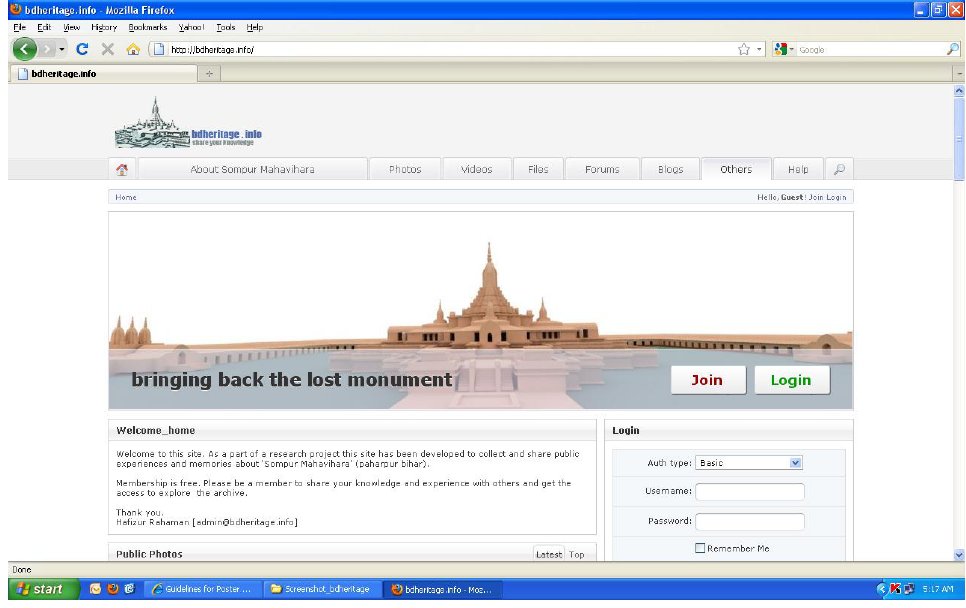
Fig. 5: Screenshot of the web portal . (Rashid, Hafiz,